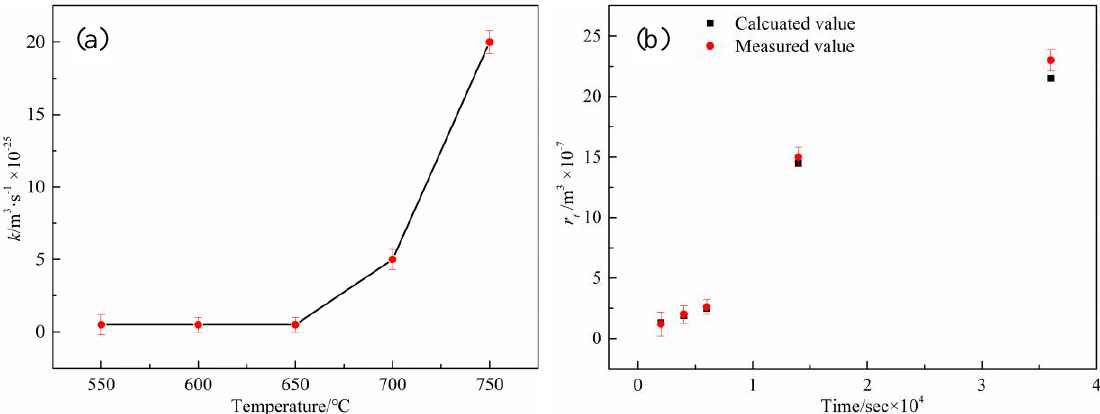
Figure 10. Calculation of coarsening rate of precipitates ( a ) at different aging temperatures with 2 h, ( b ) comparison of the calculated and measured precipitates inside the grains at 650 °C with different aging times.